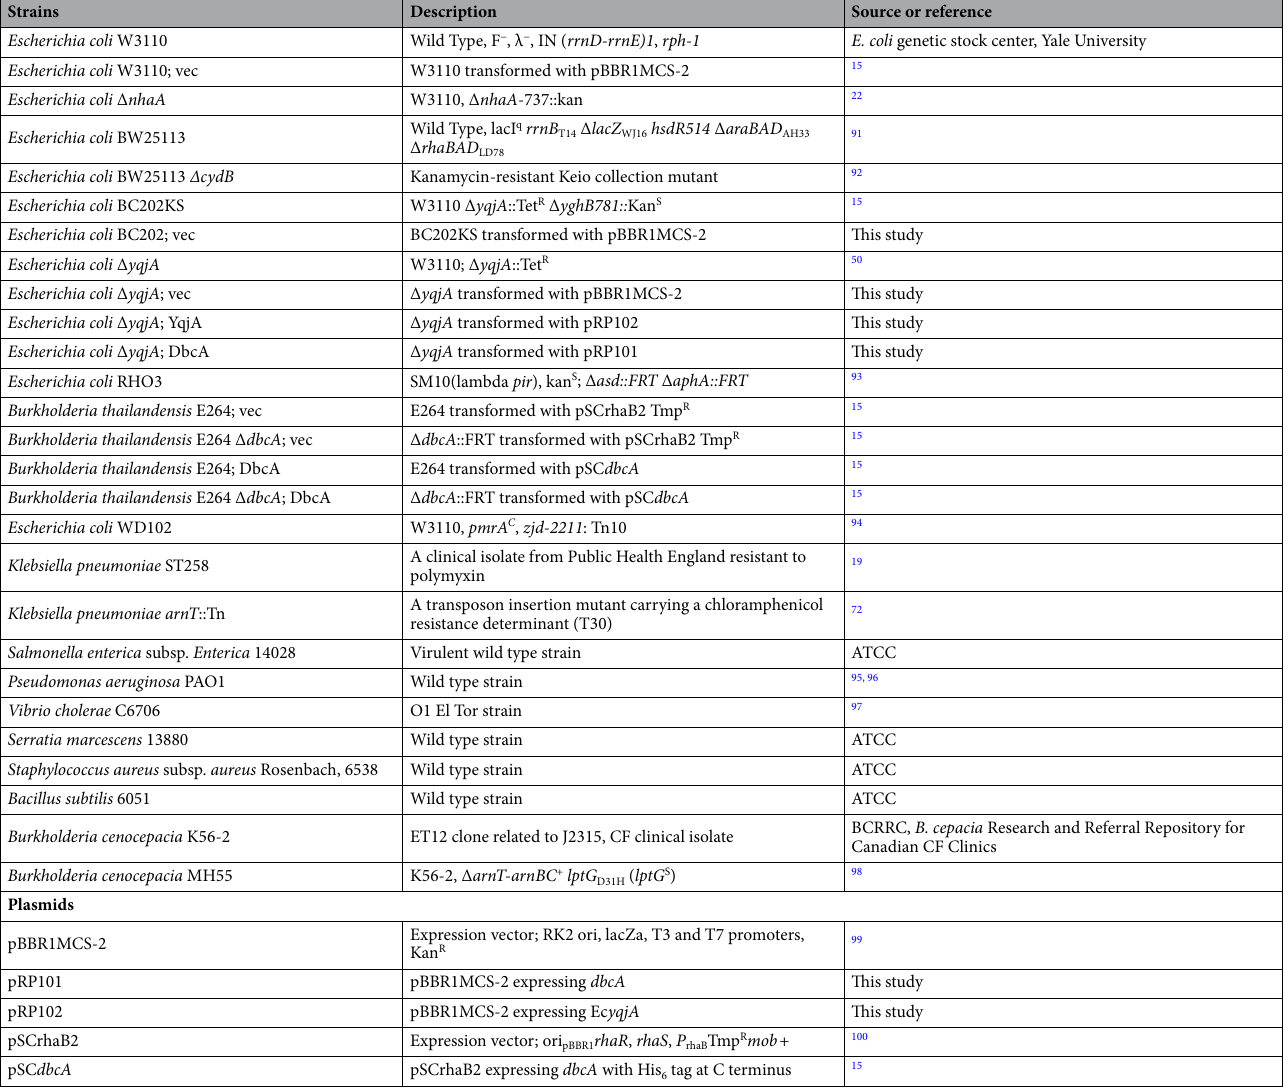
Table 1. Bacterial strains and plasmids used in this